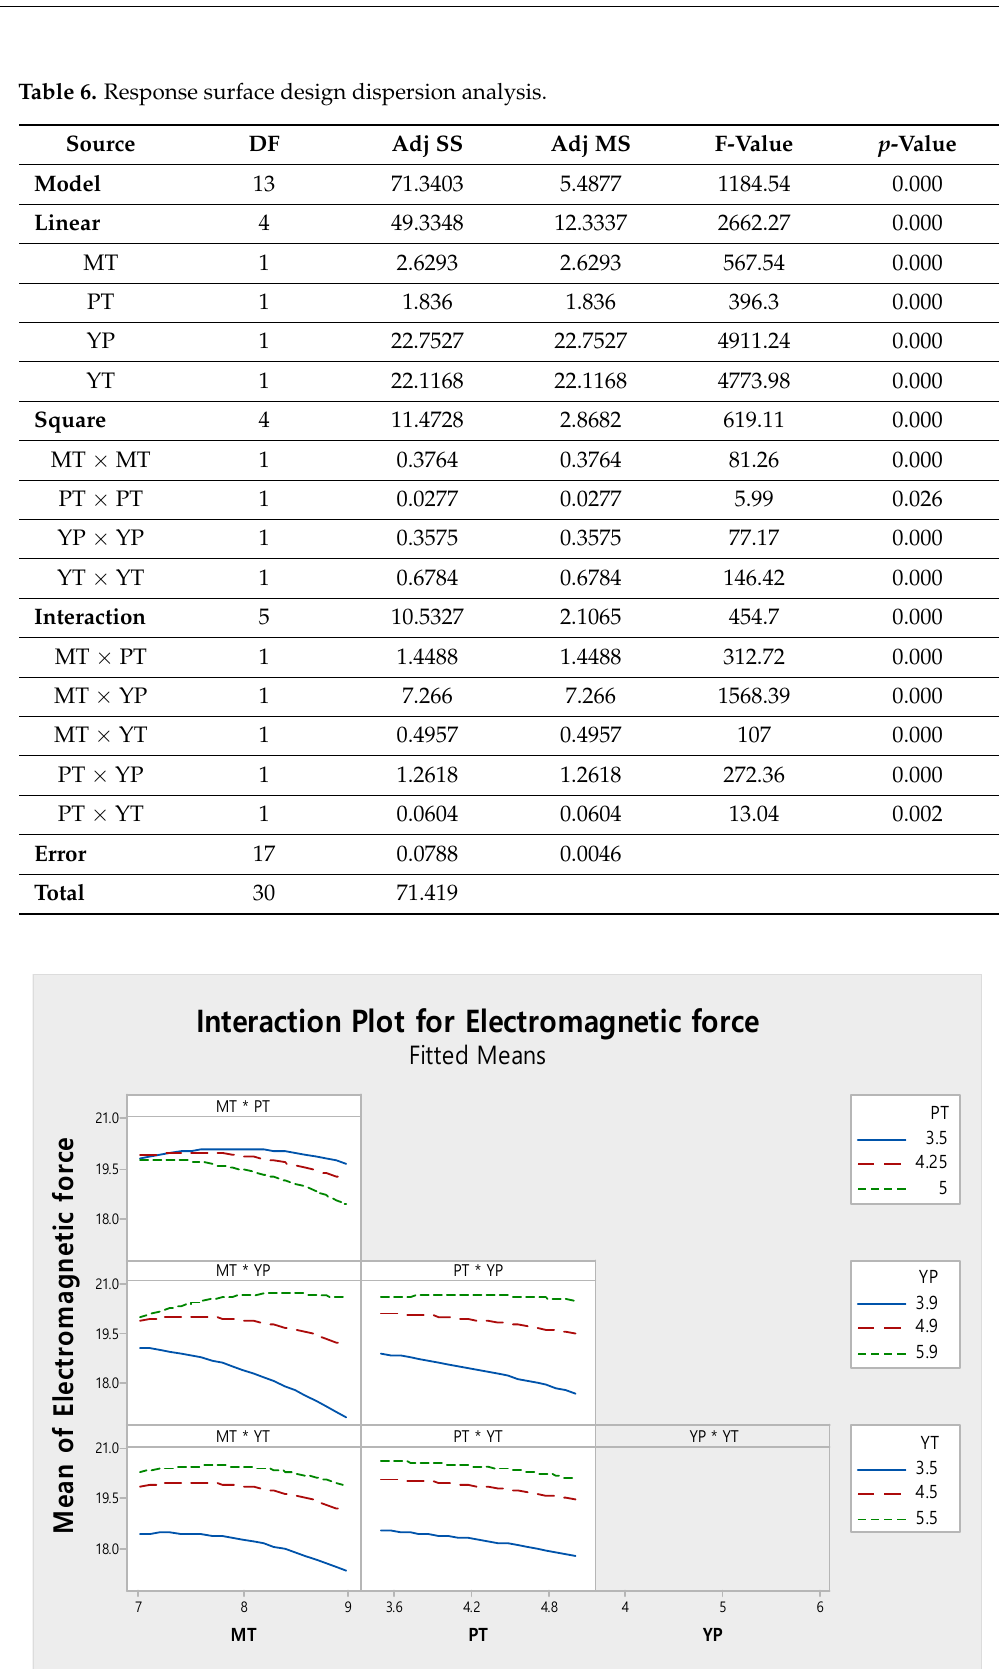
Figure 8. Interaction effects plot for electromagnetic force.